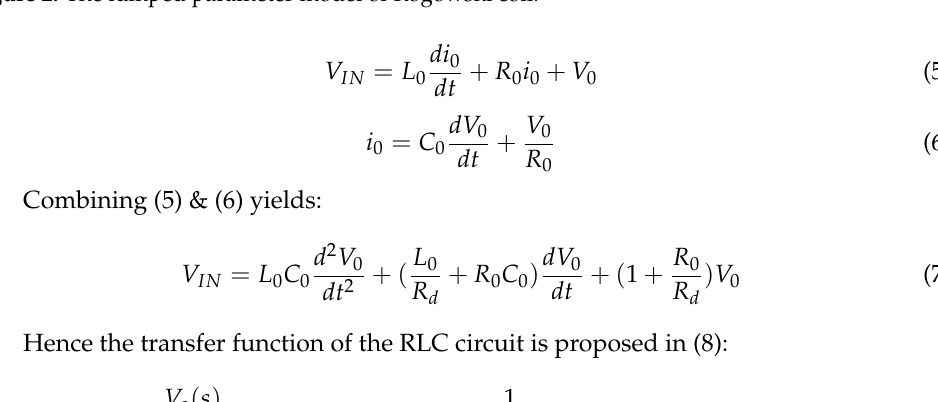
Figure 2. The lumped parameter model of Rogowski coil.